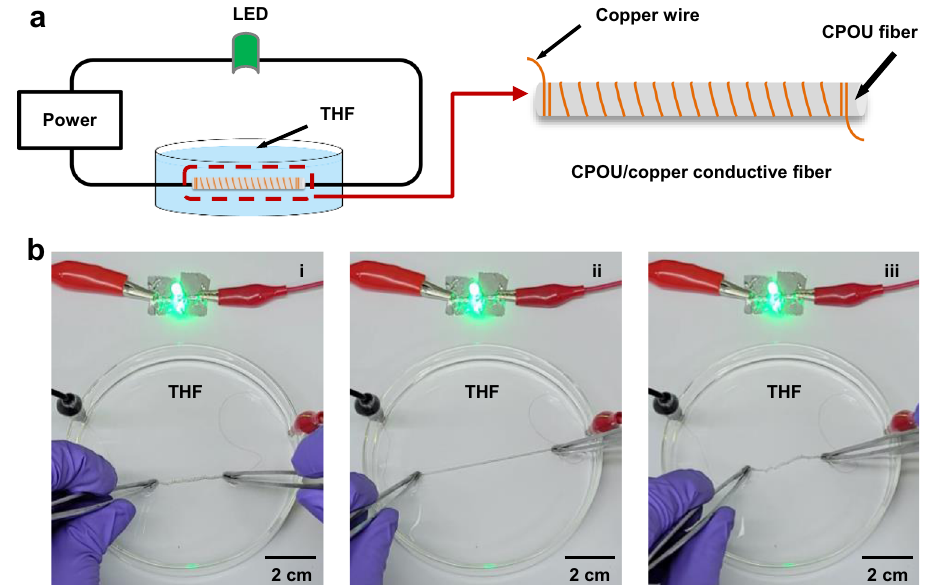
Fig. 5 | Organic solvent resistant and stretchable conductive fi ber made of CPOU. a Schematic of the electronic circuit consisting of the CPOU/copper con- ductive fi ber. b Demonstration of the organic solvent resistant and stretchable